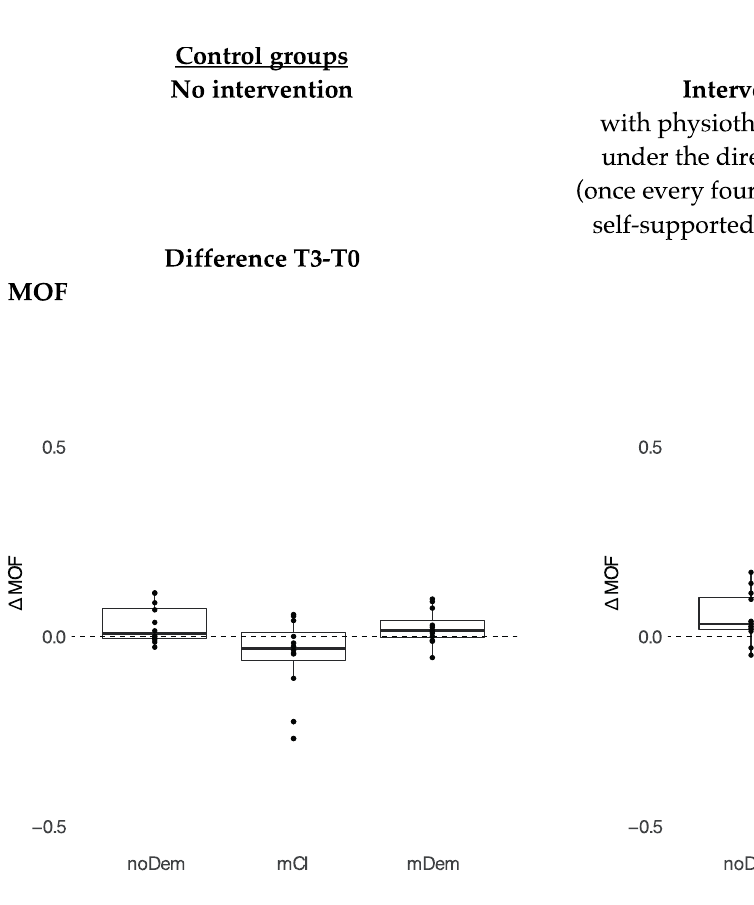
Figure 2. Visualization of the differences in ( a ) chewing efficiency (Variance of Hue, VOH) and ( b ) maximum occlusal force (MOF) as an expression of the changes over time in subjects without the intervention of the MaMuT (masculatory muscle training) program (control groups) and in subjects with the MaMuT program (experimental groups) (subgroups: noDem—no dementia, mCI—mild cognitive impairment, mDem—mild dementia). The differences between time points for VOH and MOF are calculated as ∆VOH and ∆MOF. VOH—negative differences as an expression of improvement of the chewing efficiency and vice versa/MOF— positive differences as an expression of improvement of the bite force and vice